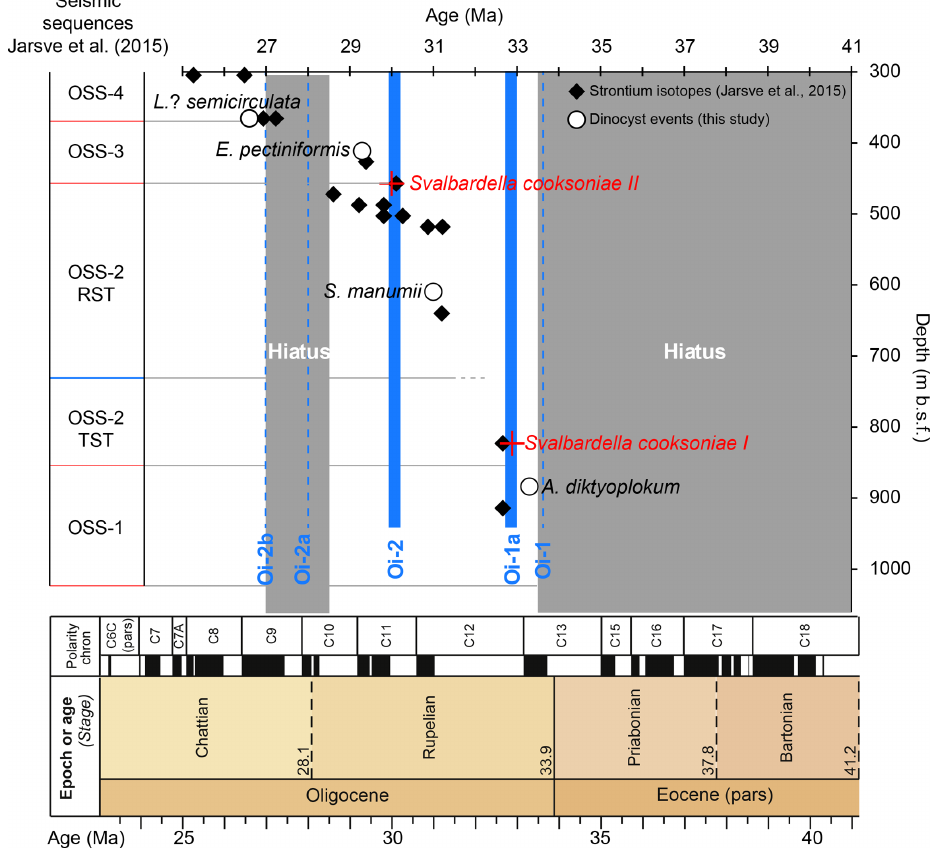
Figure 2. The updated age model for the 11/10-1 well and the time span of possible hiatuses. The dinocyst events (white circles; this study) and strontium (Sr) isotopes (black diamonds; Jarsve et al., 2015) are plotted against the GTS2012 (Vandenberghe et al., 2012). The position of the Oi events against the polarity zones is based on the δ 18 O record from ODP Site 1218; the Oi-1 and the Oi-1a are plotted after Galeotti et al. (2016), while Oi-2, Oi-2a and Oi-2b are plotted after Wade and Pälike (2004). Even if the base Chattian is now positioned in the lower part of C9n (Coccioni et al., 2018), the hiatus in well 11/10-1 will still span the Rupelian–Chattian boundary. Dinocyst events consist of last occurrences (LOs) which are dated as follows: the LO of Licracysta ? semicirculata – 28.5Ma (Williams et al., 2004), the LO of Enneadocysta pectiniformis – 29.3Ma (Williams et al., 2004), the LO of Spiniferites manumii – 30.8Ma (Eldrett et al., 2004) – the LO of Areosphaeridium diktyoplokum – 33.3Ma (Eldrett et al.,